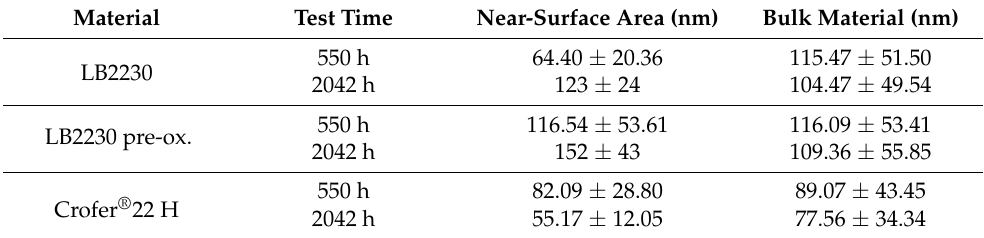
Figure 6. SEM images of Laves phases precipitation in LB2230, pre-oxidized LB2230 and Crofer ® 22 H after 550 h of discontinuous corrosion testing in solar salt at 600 ◦ C. Table 3. Mean equivalent circle diameters and standard deviation of Laves phase particles near the surface (down to 6 µ m depth) and the material bulk (depth of investigated area from 100 to 200 µ m) in LB2230, pre-oxidized LB2230 and Crofer ® 22